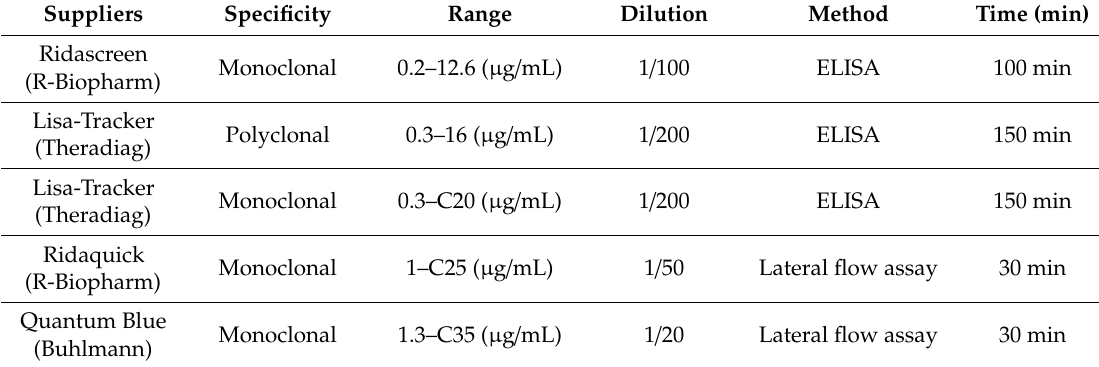
Table 3. Technical characteristics of the di ff erent assays used for the measure of ADA trough